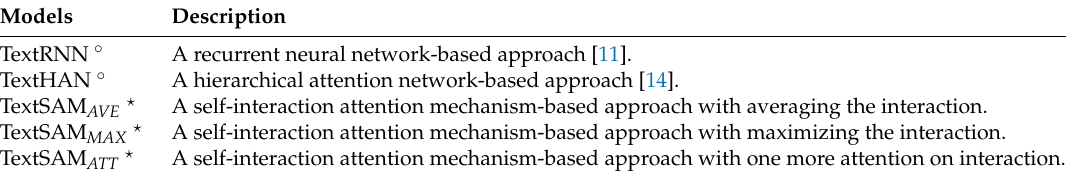
Table 1. Models summary. (The baseline methods and our proposals are identified with the identifiers ◦ and (cid:63) ,